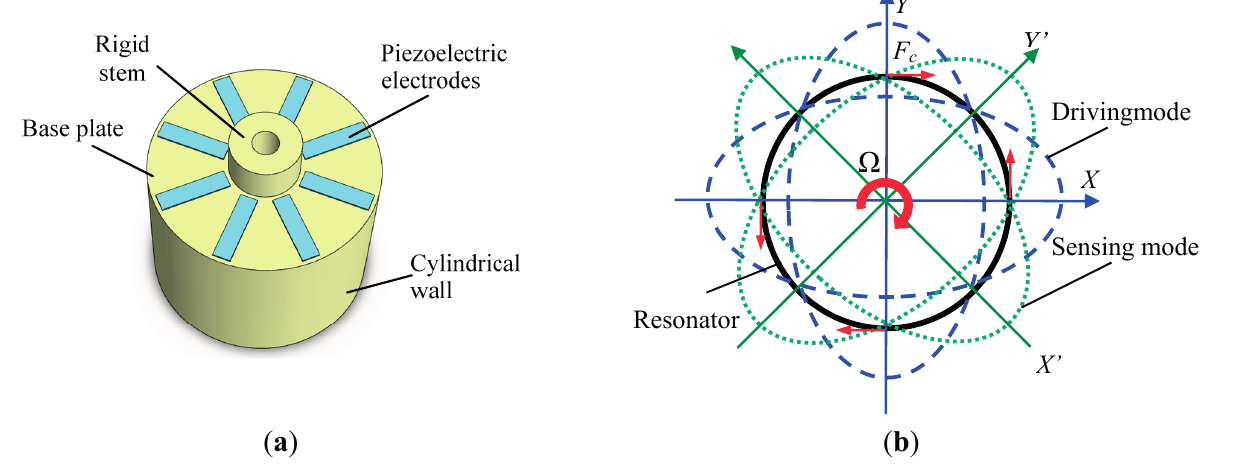
Figure 1. ( a ) Structure of the vibratory cylinder gyroscope; ( b ) Schematic of the operation principle.